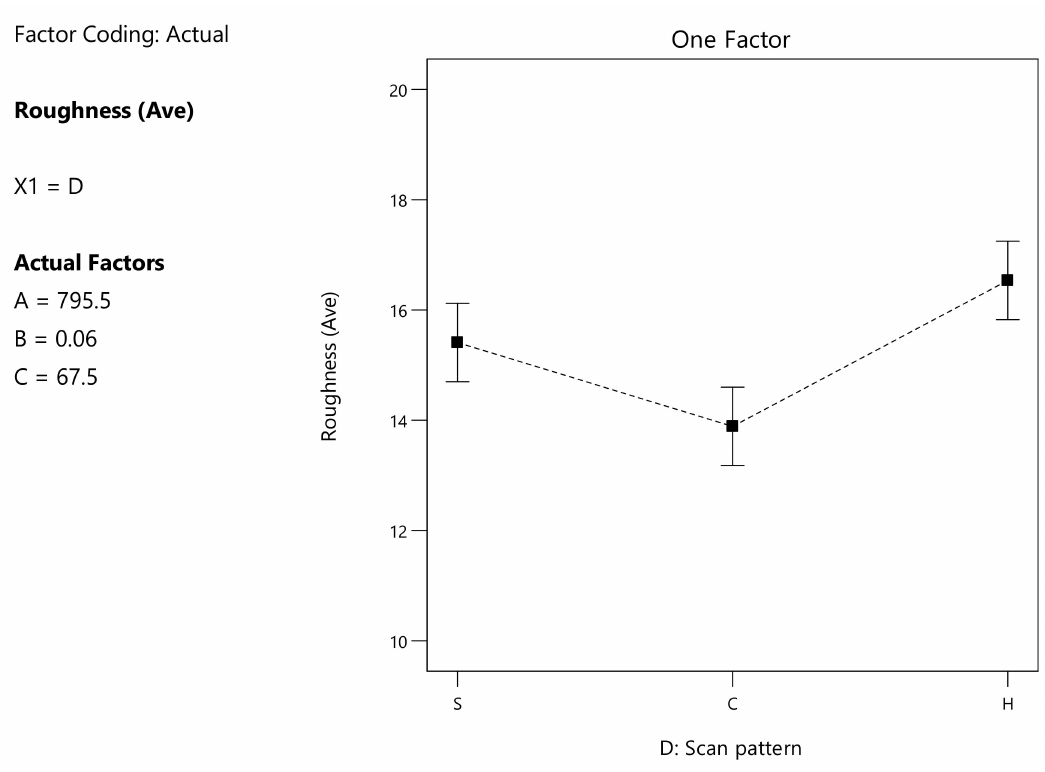
Figure 11. Influence of the scanning strategy on the average surface roughness Ra ( µ m) of the